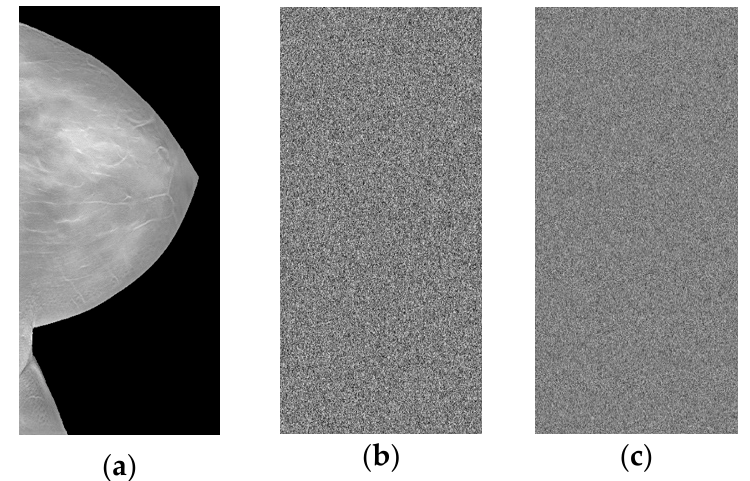
Figure 12. ( a ) the original image, ( b ) the encrypted image (Frame-Based SE), and ( c ) the encrypted image (Holistic-Based SE).